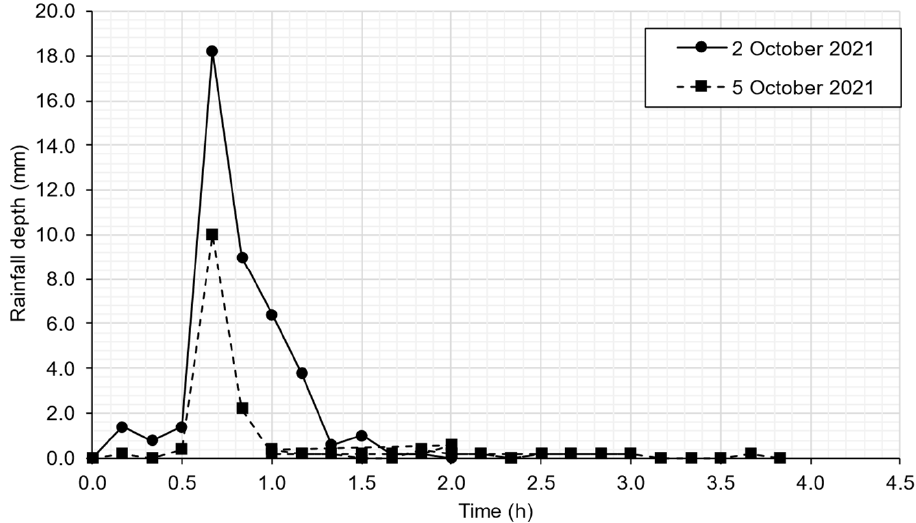
Figure 7. Manhole overflow at Piazza Castelforte. Source: web (www.palermotoday.it accessed on